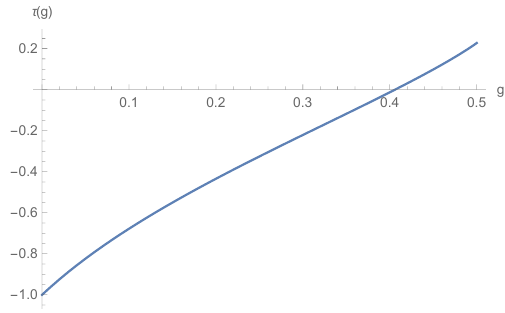
Figure 7: Shifted exponential Lorenz Copula Kendall’s τ SE as a function of g